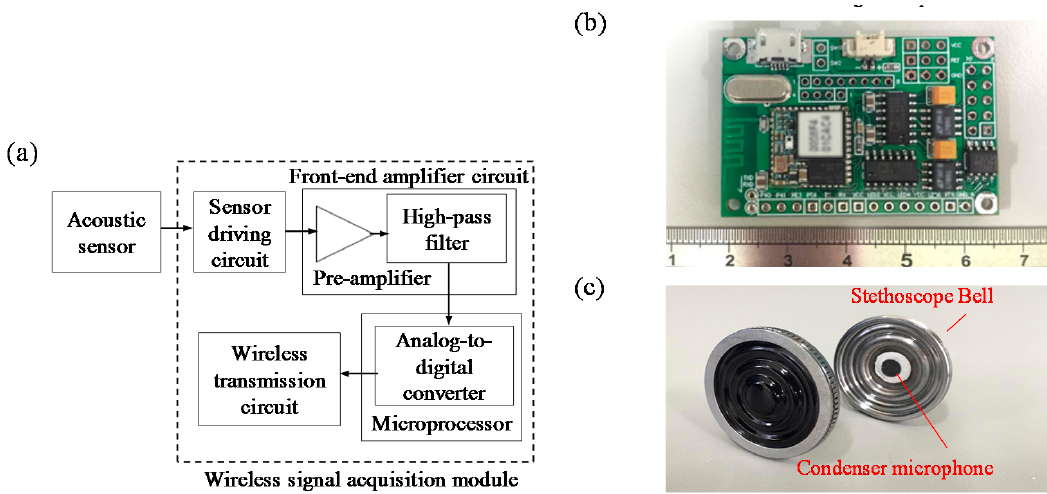
Figure 2. ( a ) Block diagram and ( b ) photograph of proposed wireless breathing sound acquisition module and ( c ) photograph of acoustic sensor.